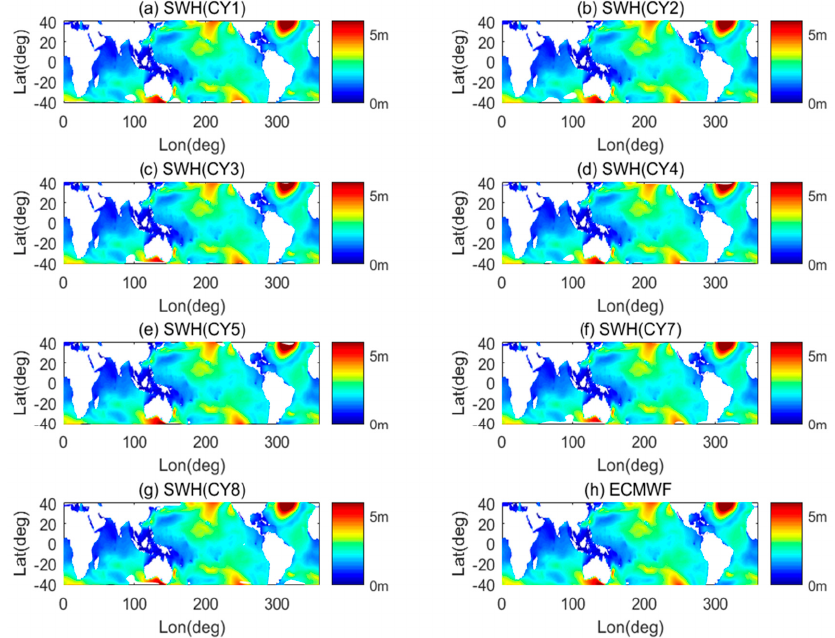
Figure 6. The CYGNSS significant wave height (SWH) estimates compared with the European Centre for Medium-Range Weather Forecasts (ECMWF) SWH model on 1 April 2017 (including CY1, CY2, CY3, CY4, CY5, CY7, and CY8 satellites).